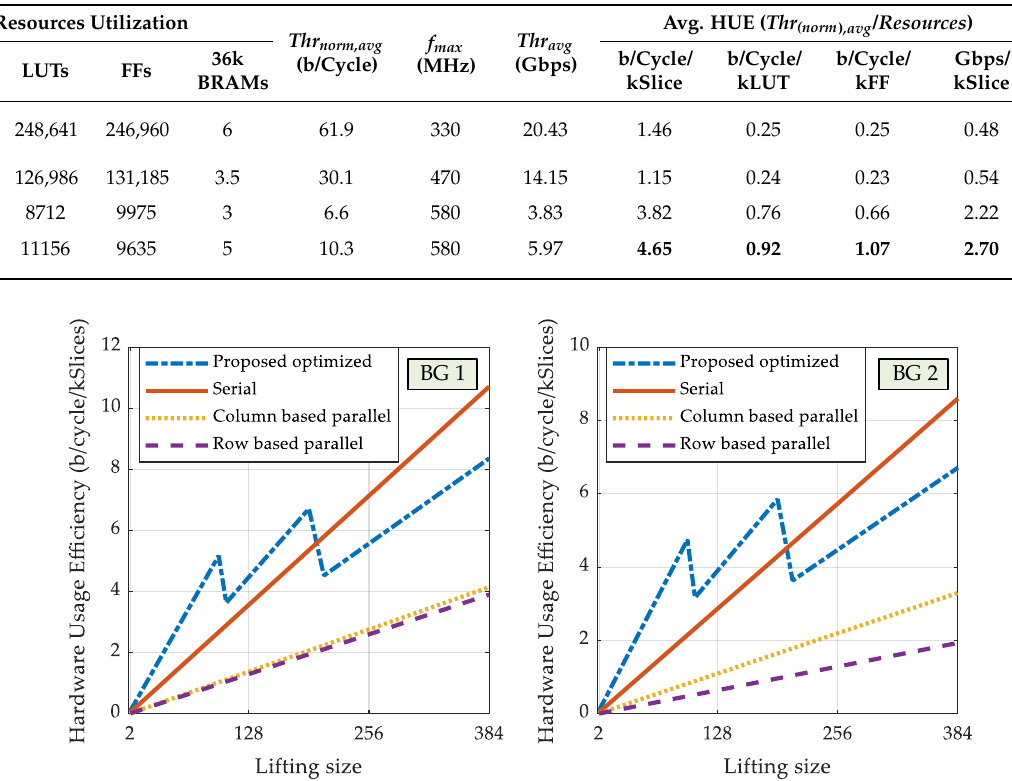
Table 3. Implementation results for various architectures of 5G NR LDPC encoder and average throughput and hardware usage efficiency comparison.